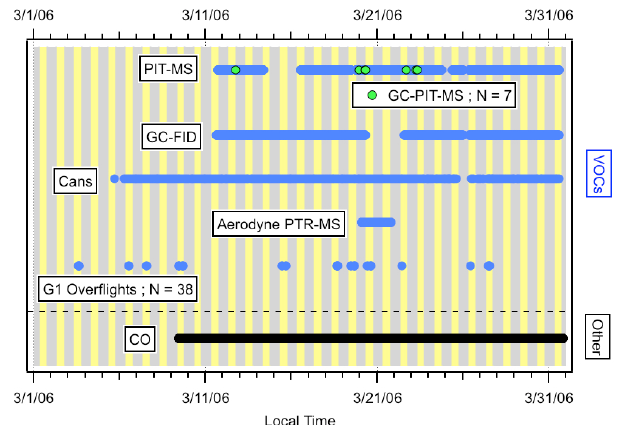
Figure 1. Sampling periods for the VOC measurement methods and CO at the T1 ground site in 983 Fig. 1. Sampling periods for the VOC measurement methods and Mexico City during the MILAGRO campaign. Approximate daylight hours (7:00 AM – 19:00 PM 984 CO at the T1 ground site in Mexico City during the MILAGRO local time) are shown in yellow. 985 campaign. Approximate daylight hours (07:00–19:00local time) are shown in